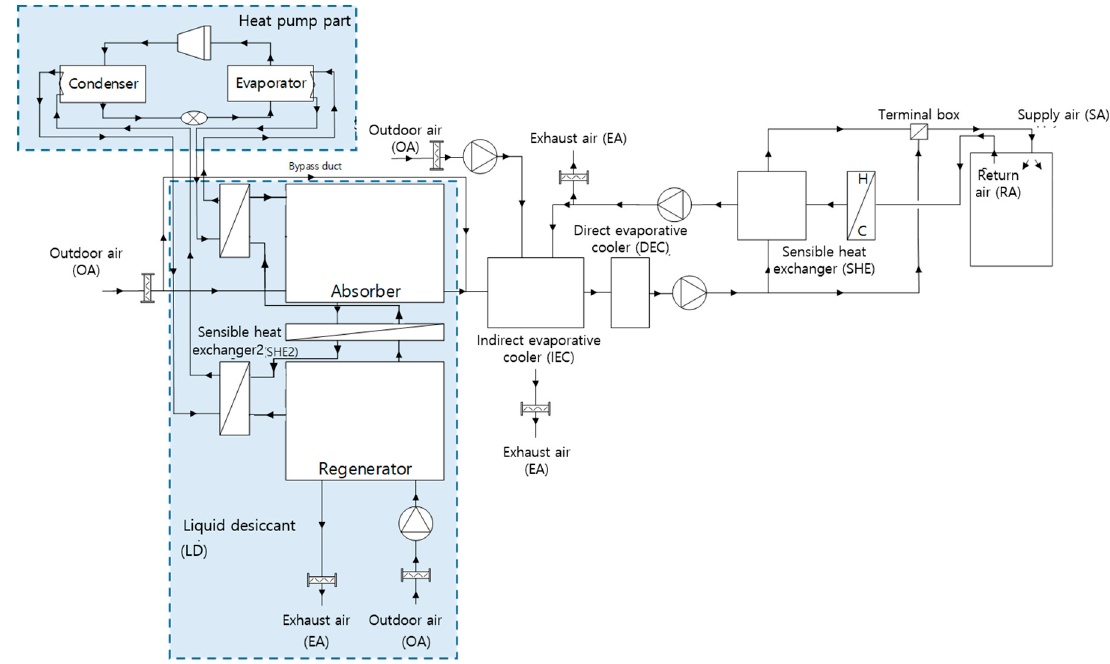
Figure 1. Schematic diagram of HPLD-IDECOAS.